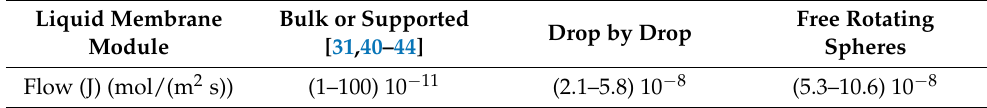
Table 3. Comparative flows of aromatic derivatives through membrane systems.